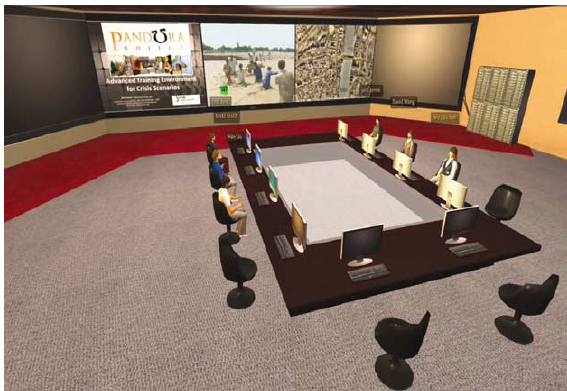
Figure 1. The virtual training